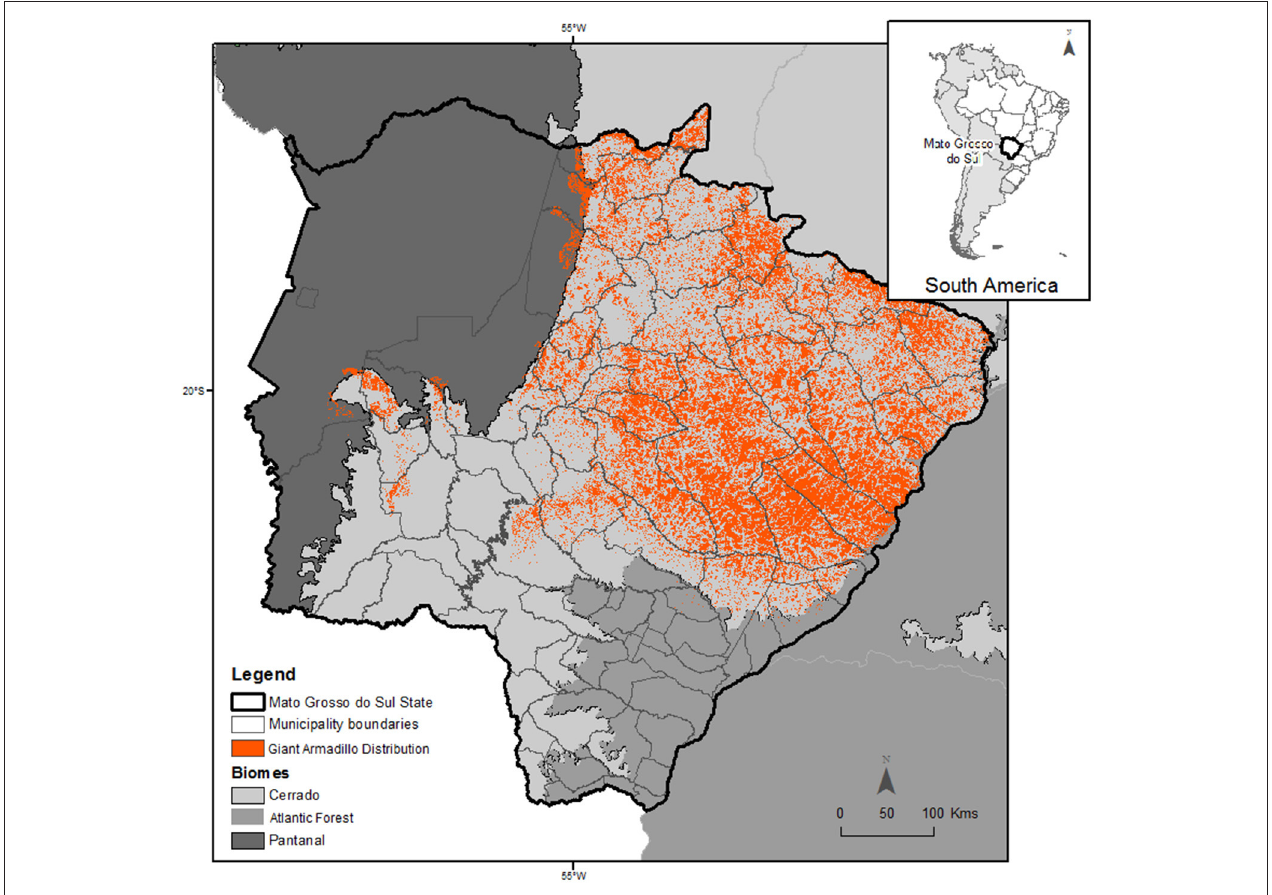
FIGURE 1 | Giant armadillo ( Priodontes maximus ) distribution in the Cerrado biome of Mato Grosso do Sul state, Brazil (Ferraz et al.,